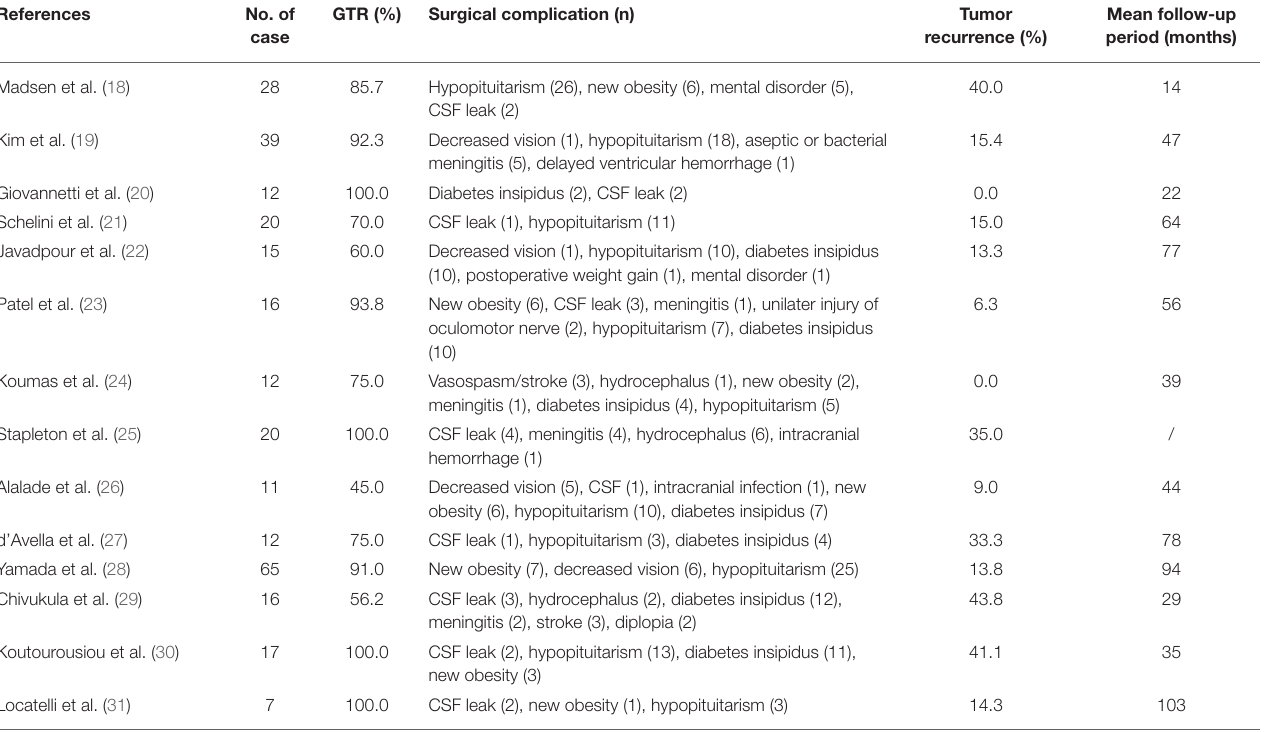
TABLE 2 | The summary of surgical cases of pediatric patients with craniopharyngiomas removed by endoscopic trans-nasal approach from the literature since 2010 *